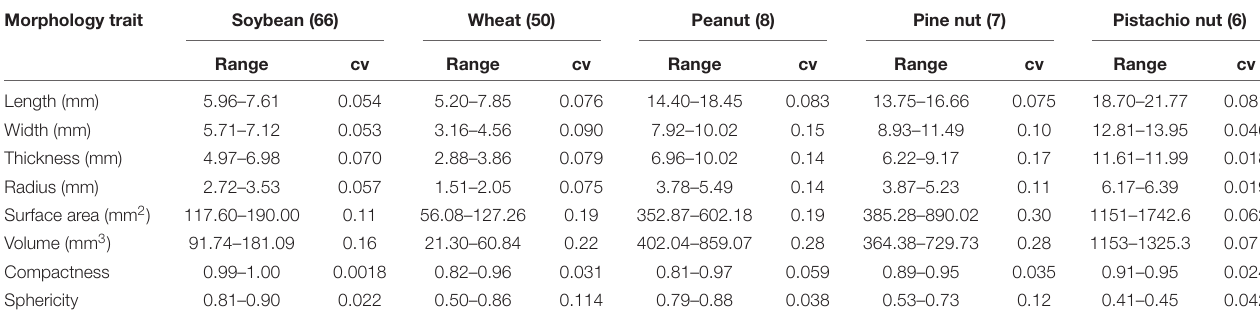
TABLE 2 | The summary of external morphological phenotypes of soybean, wheat, peanut, pine nut, and pistachio nut seeds extracted from X-ray CT images using the 3DPheno-Seed&Fruit software. Morphology